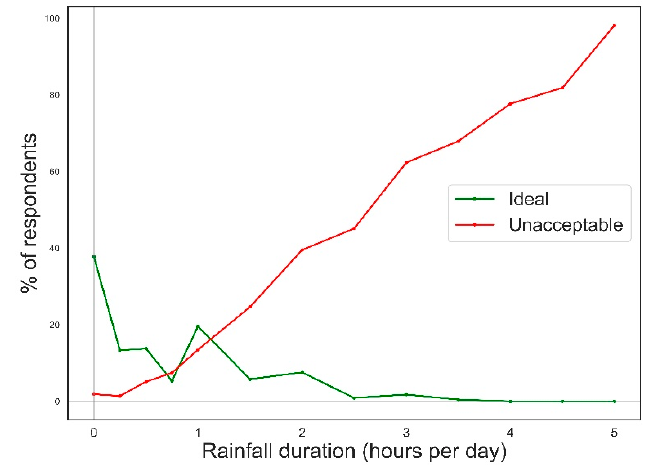
Figure 8. Percentage of respondents considering a rainfall duration as ideal (green line) and unacceptable (red line).